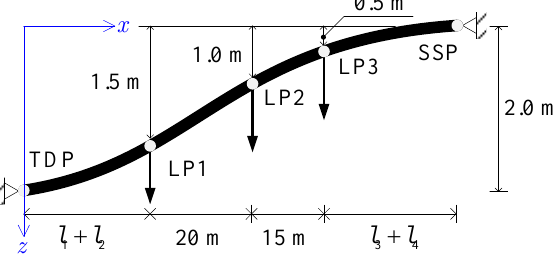
Figure A2. Segmental pipeline model in the lateral plane with 3 pipelayers